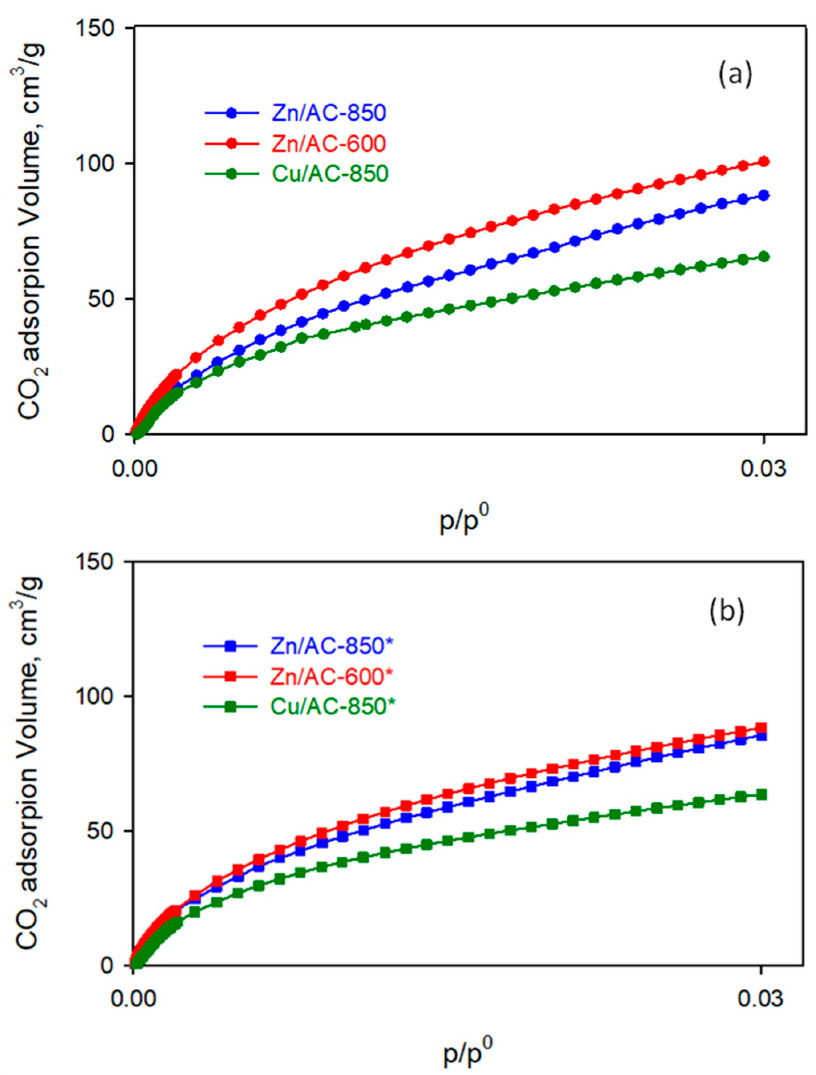
Figure 8. CO 2 physisorption isotherms at 273 K for activated carbons pyrolyzed under pure helium ( a ) and under O 2 /He mixture ( b ).